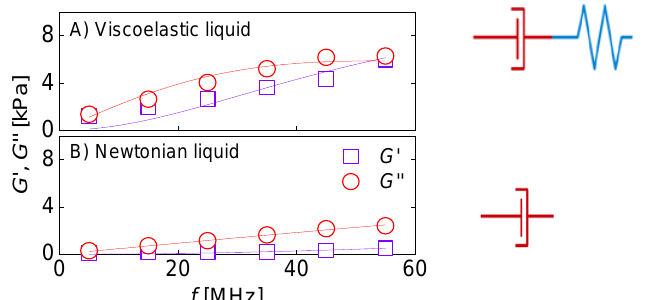
Figure 14. The complex shear modulus of two concentrated antibody solutions as determined with a QCM and Equation (31). The lines are fits with a Maxwell model ( G (cid:48) + i G (cid:48)(cid:48) = G ∞ (cid:48) / ( 1 − i ωτ ) ). The top and the bottom show data obtained on a viscoelastic liquid ( A ) and on a Newtonian liquid ( B ), respectively. Adapted from [70].